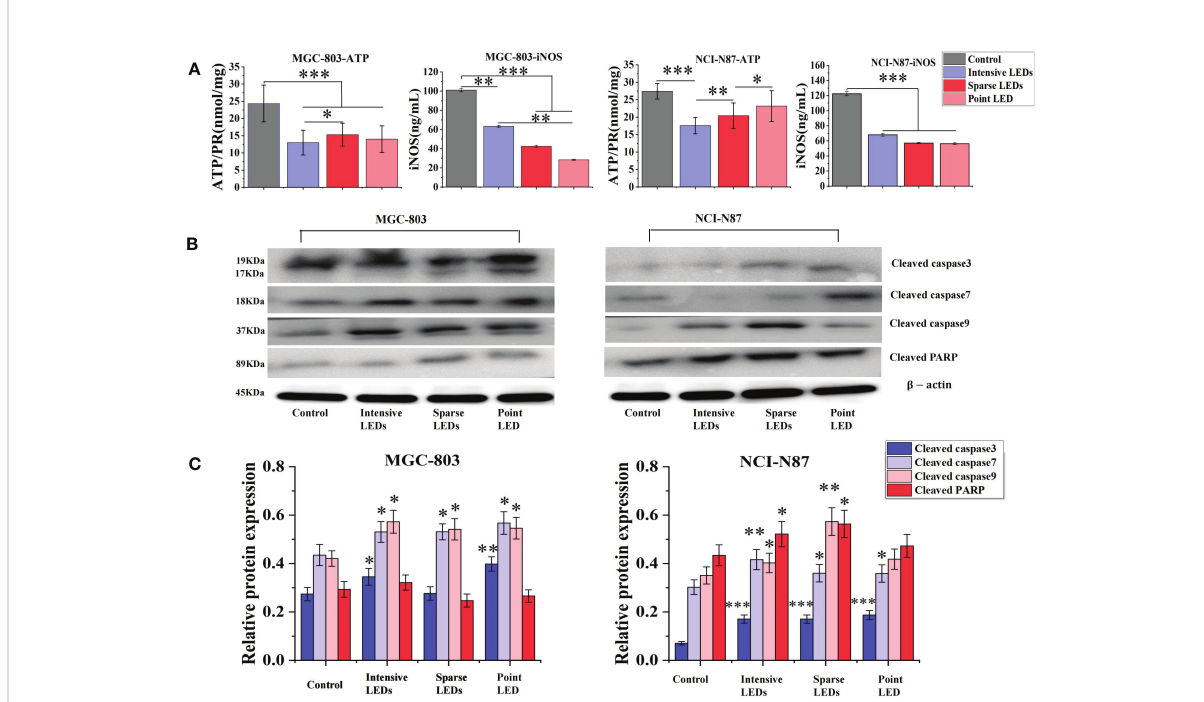
FIGURE 4 Apoptosis of GI cancer cells induced by PDT with different light fi elds. Cells were fi rst irradiated with the intensive LED, sparse LED, and point LED arrays, and then the apoptosis-related factors and apoptosis-related proteins were detected. (A) Apoptosis-related factors: Cells were collected, and the content of ATP and iNOS were quanti fi ed following the kit instructions. (B) Apoptosis-related proteins: Western blotting analysis was used to evaluate the cleaved products of apoptosis-related proteins (cleaved caspase3, cleaved caspase7, cleaved caspase9, and cleaved PARP) in cell samples at 6 h after PDT, and the relative protein expression was quanti fi ed using ImageJ (C) . (*P < 0.05, **P < 0.01, ***P < 0.001 by one-way ANOVA. Mean ± SD in bar